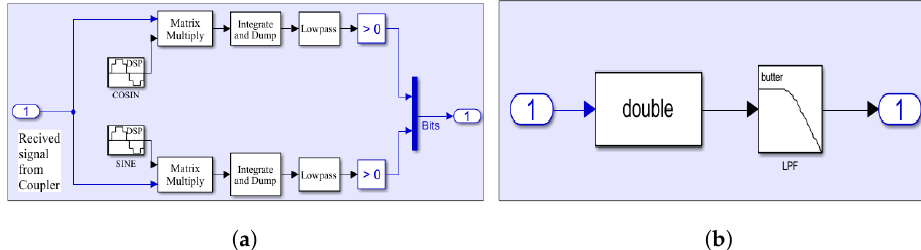
Figure 8. SIMULINK implementation of the ( a ) QPSK demodulator and ( b ) the digital-to-analog converter.